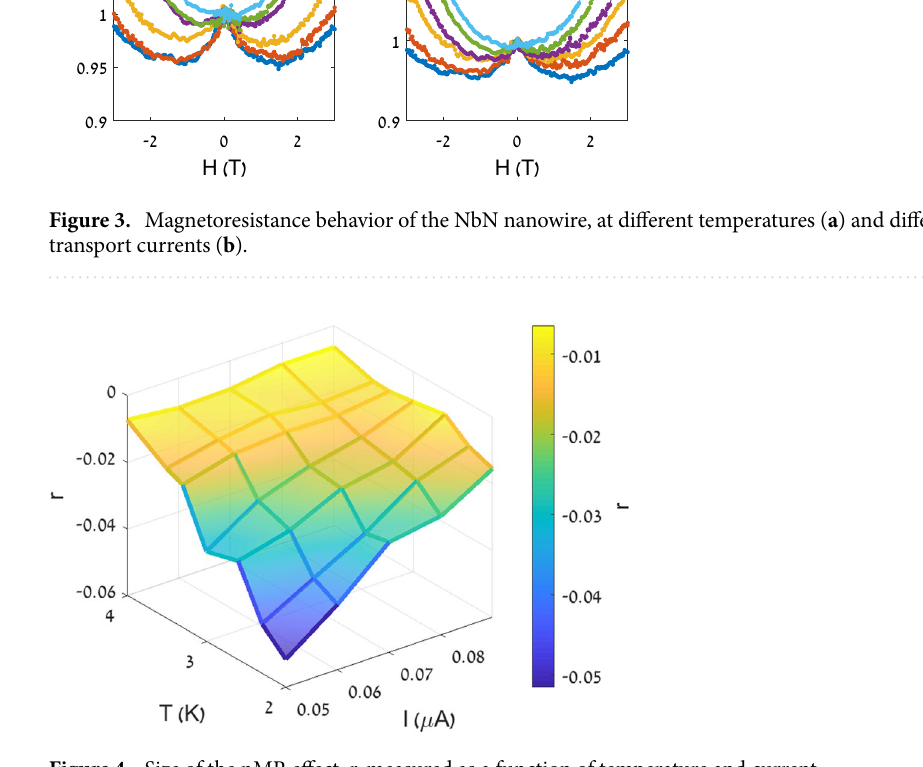
Figure 4. Size of the nMR effect, r, measured as a function of temperature and